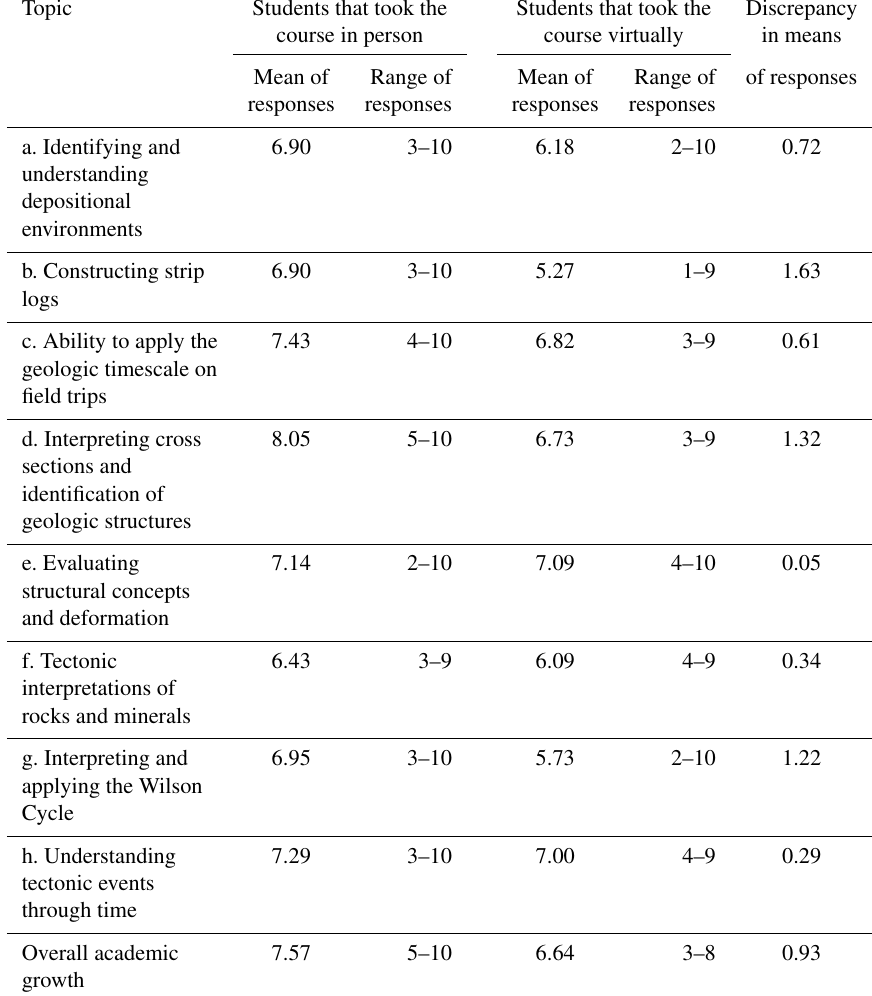
Table 2. Student survey responses highlighting self-evaluation of academic growth from the beginning to the end of the Stratigraphy, Struc- ture, Tectonics (SST) course. Responses are grouped by whether the students took the course in person ( n = 21) or virtually ( n = 11). Key topics highlighted include those with a stratigraphic focus (a–c), those with a structural focus (d and e), and those with a tectonics focus (f–h). Academic growth is reported on a scale of 1–10, where 1 = little academic growth and 10 = the most academic growth possible; means of responses and ranges of responses are